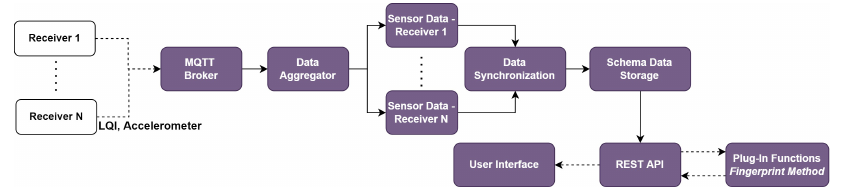
Figure 17. Function flow for FILS15.4 in platform.